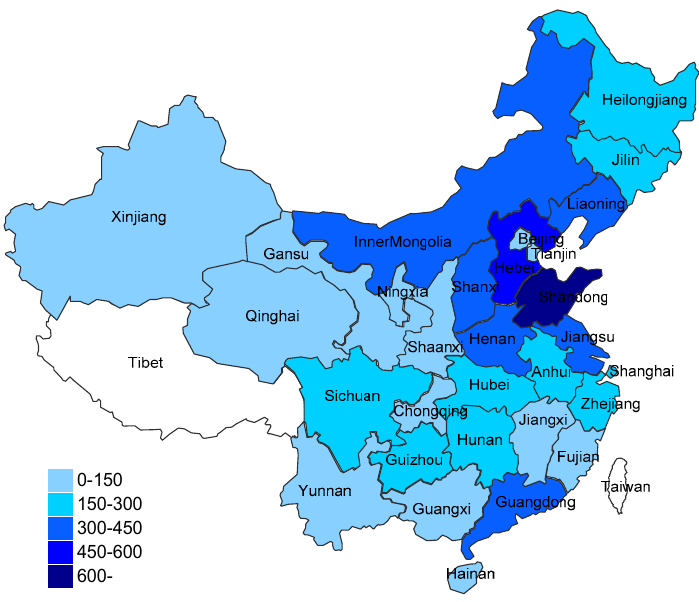
Figure 3. Regional CO 2 emissions in China (Mt).